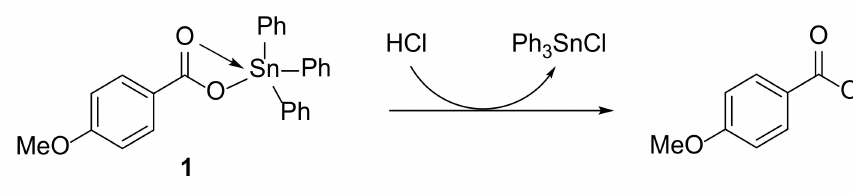
Scheme 3. Complex 1 acts as a HCl scavenger.